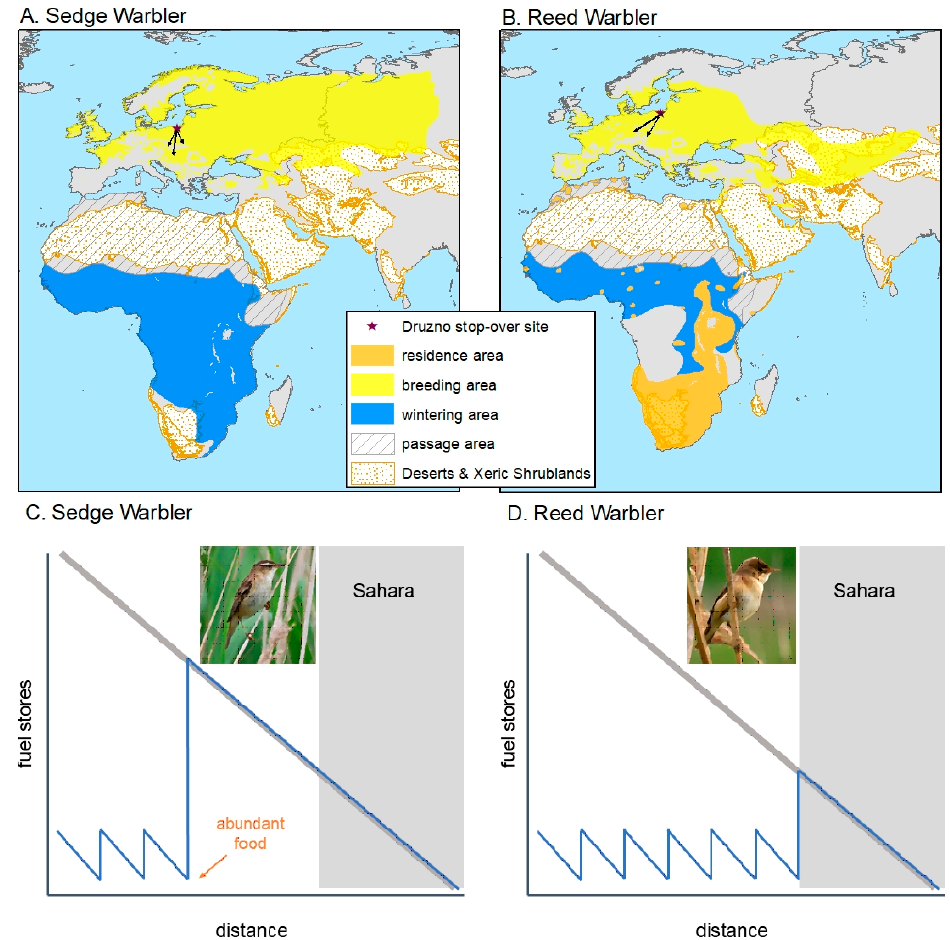
Figure 1. Breeding, wintering and passage areas of the sedge ( A ) and Reed Warblers ( B ) [17]. The range of Sahara desert habitats (biomes Deserts & Xeric Shrubland and Flooded Grasslands & Savannas) is according to Ecoregions2017© Resolve [18]. Summary of the refuelling strategies along Atlantic migration flyway from the breeding grounds in Europe to sub-Saharan Africa in terms of fuel stores for Sedge Warbler [( C ); start of non-refuelling migration when encountering superabundant food, well before the Sahara (grey box)] and Reed Warbler [( D ); large fuel deposition just before the Sahara (grey box)] according to [14]. The diagonal grey bar-line indicates the fuel load needed for flying to the southern border of the Sahara (grey area) without refuelling. Main migration directions of sedge and Reed Warbler populations (black arrows) migrating through the stop-over site in “Druzno Lake” reserve (black star) based on data from ringing recoveries from this site (after [19]).